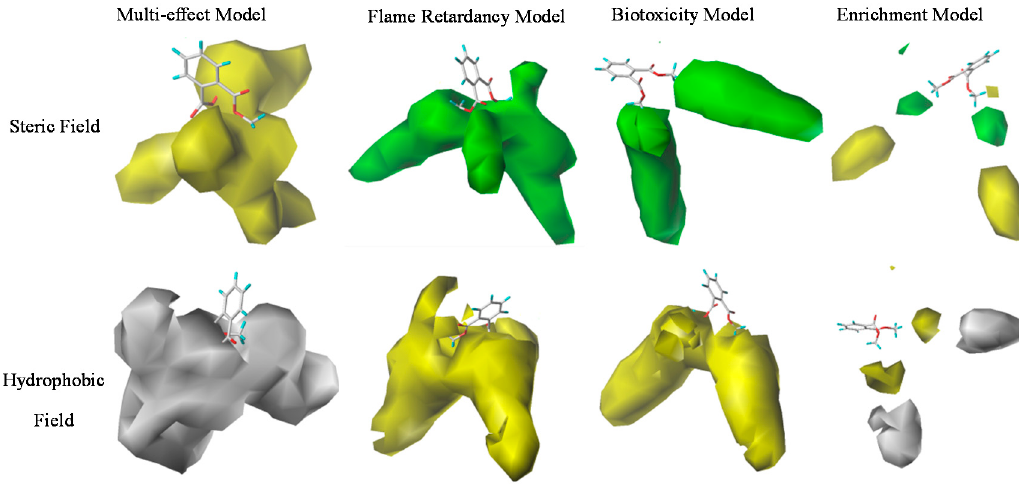
Figure 3. DMP’s three-dimensional contour maps for the multi-effect model and single-effect models of PAEs’ flammability, biotoxicity, and